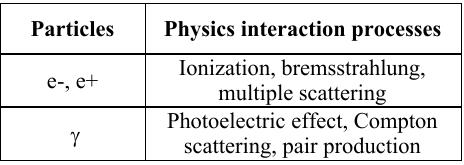
Table 1. Initial proposed physics